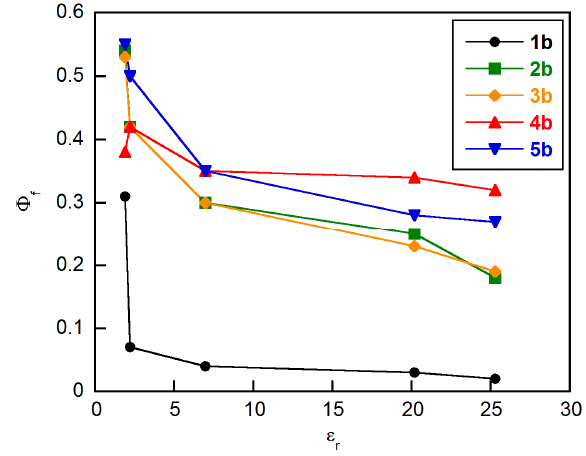
Figure 2. Relationship between fluorescence quantum yields ( Φ f ) of closed-ring isomers 1b - 5b and the relative dielectric constants ( ε r ) of the solvents. The solvents used were n -hexane ( ε r = 1.89), 1,4-dioxane ( ε r = 2.22), 2MeTHF ( ε r = 6.97), 2-propanol ( ε r = 20.2), and ethanol ( ε r =